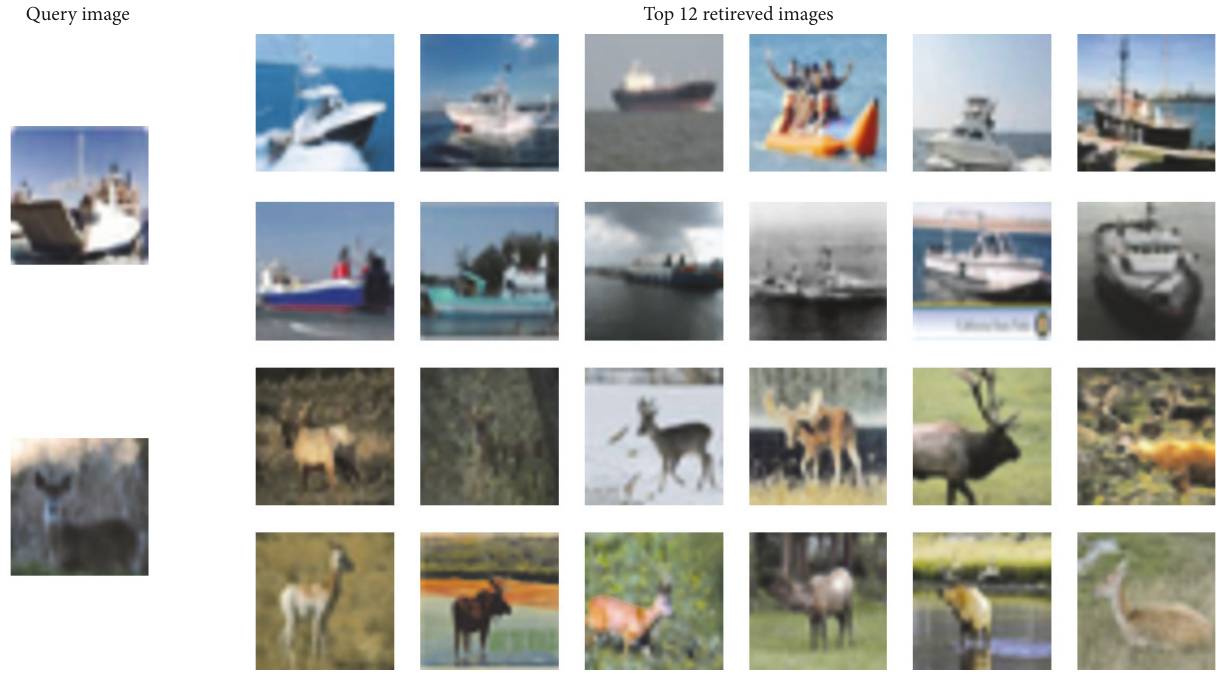
Figure 3: Top 12 retrieved images of two query image samples. The dataset is CIFAR-10 and hash length is 24 bits. As shown in the figure, the precision of high-rank retrieved images is very high.